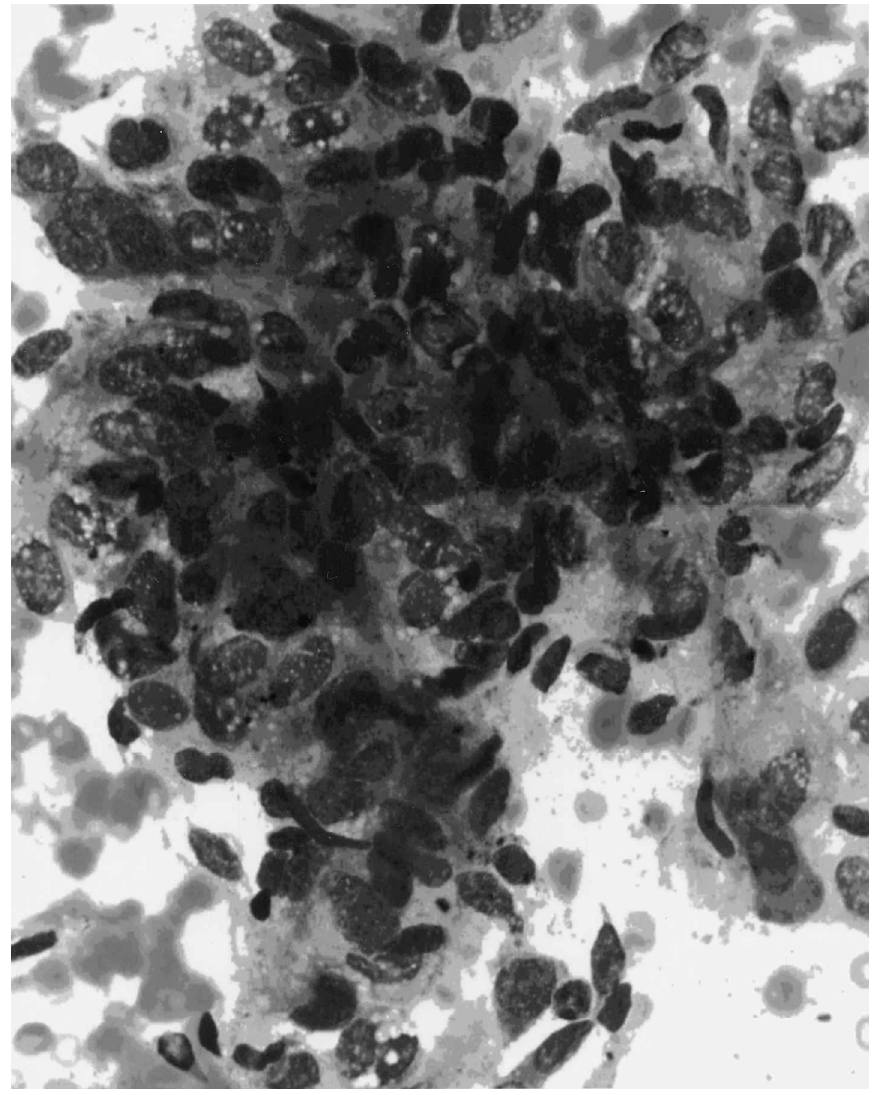
Fig.5. Cytology of GCT,shows cluster of mesenchymal cells with elongated nuclei and some vacuoles in the cytoplasm (MGG,x160). The aspirate was categorised as other malignancy by one of the cytologists and as non-conclusive by the